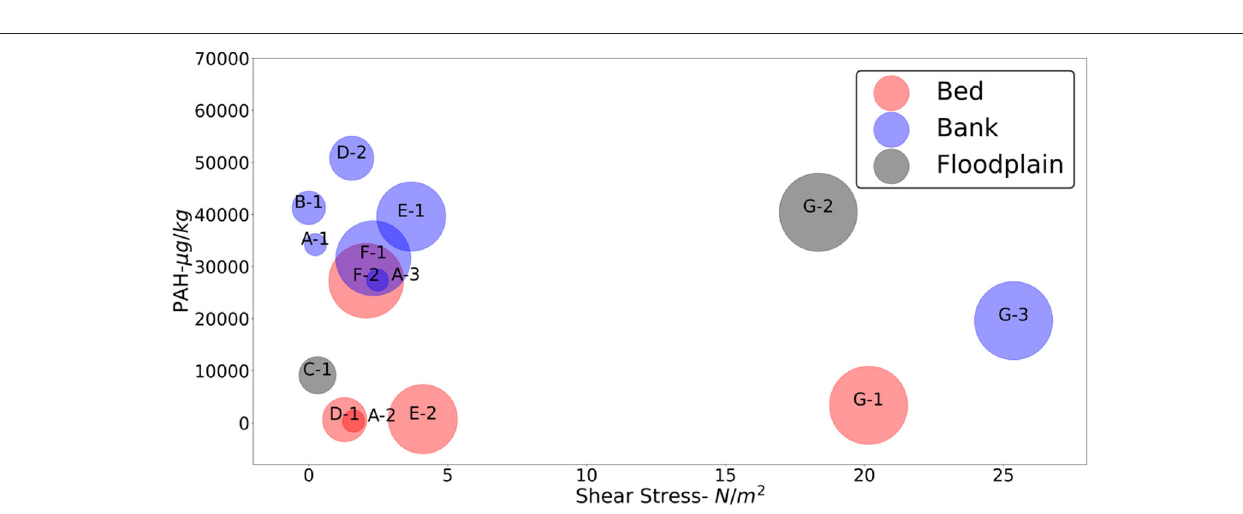
FIGURE 8 | Variations in PAHs concentration and shear stress in topsoil (average depth of 7.6cm) at the bed, the banks, and the floodplains. The bubble sizes show the distance from upstream (smallest diameter) to downstream (largest diameter). Red, blue, and gray colors are designated for the bed, the bank, and the floodplain, respectively. The names of the sampling locations are shown within or next to the